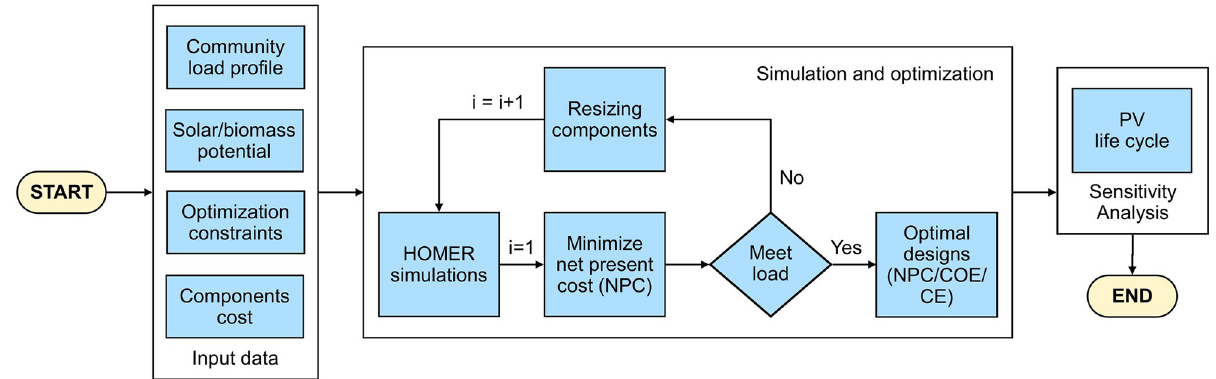
Fig 3. The flowchart of optimization